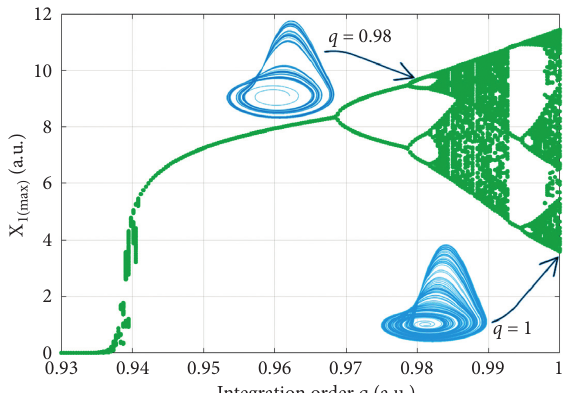
Figure 3: Bifurcation diagram of the R¨ossler system by modifying the integration order, equation (16). The abscissa axis indicates that the three oscillator state variables have the same integration order.